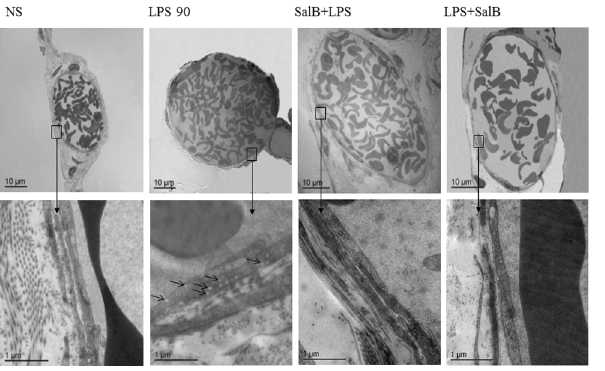
Fig 2. Effect of SalB on the number of caveolae in endothelial cells of rat microvascular venules. Displayed are electron micrograms of rat mesenteric venules in different groups with high magnifications shown below. Arrows indicate